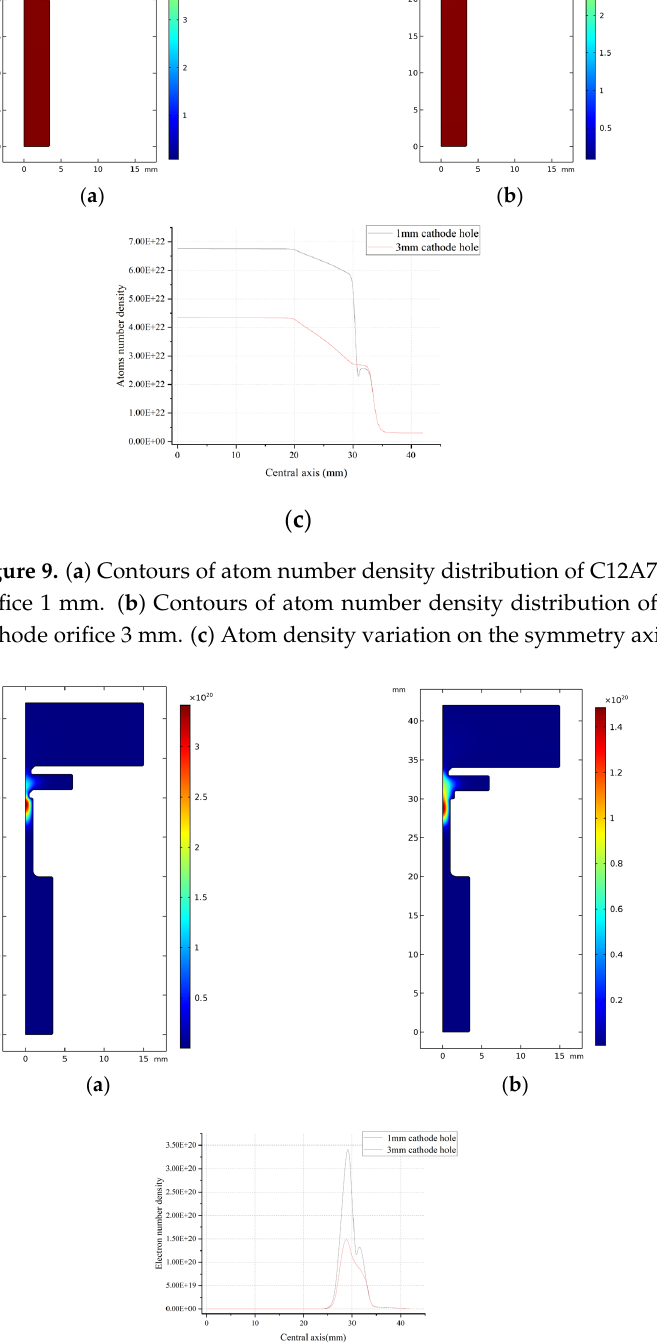
Figure 10. ( a ) Contours of electron number density distribution of C12A7 hollow cathode with cathode orifice 1 mm. ( b ) Contours of electron number density distribution of C12A7 hollow cathode with cathode orifice 3 mm. ( c ) Electron number density variation on the symmetry axis along the